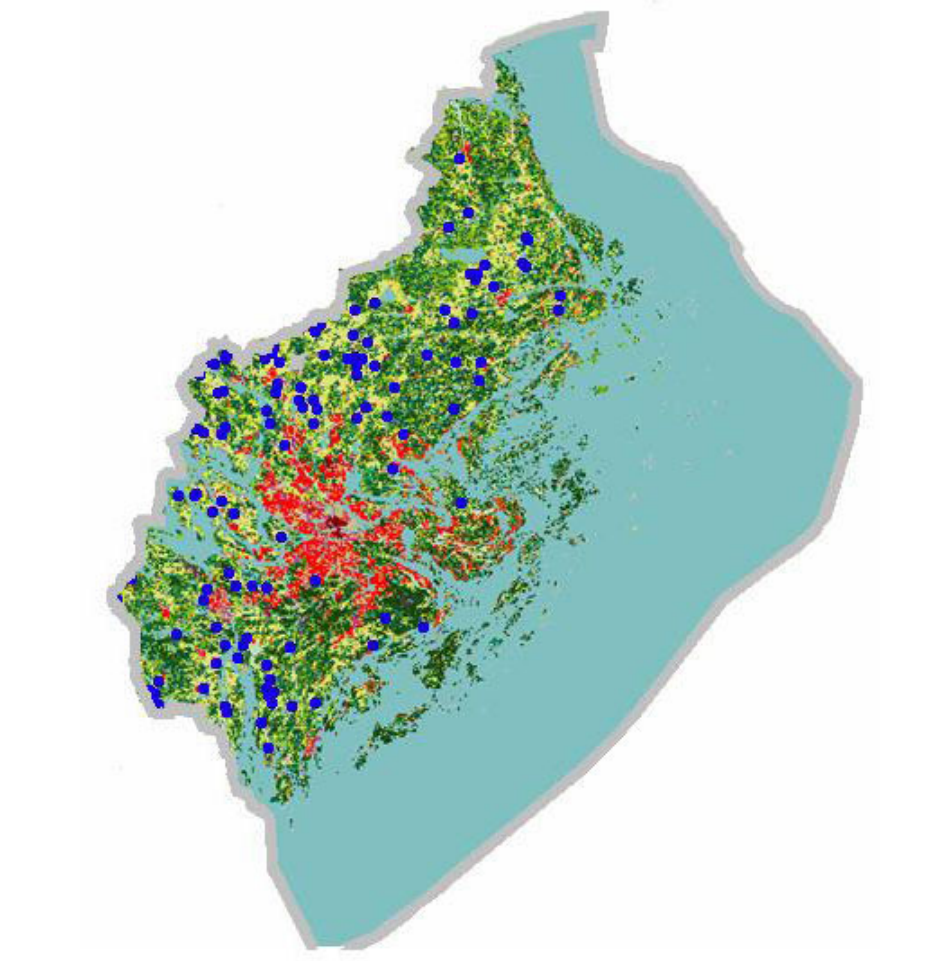
Fig. 1 . The Stockholm County, Sweden. The blue dots show the location of all oil rapeseed fields in the county in 2006 (Svenska Raps